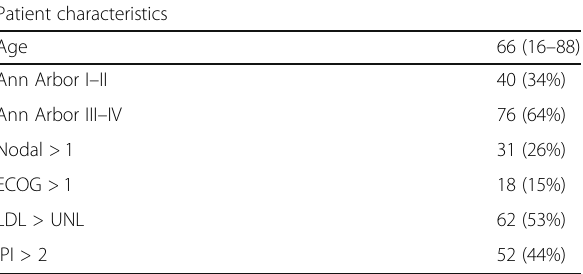
Table 2 IPI classification for patients. Pre-therapy IPI was unavailable in five